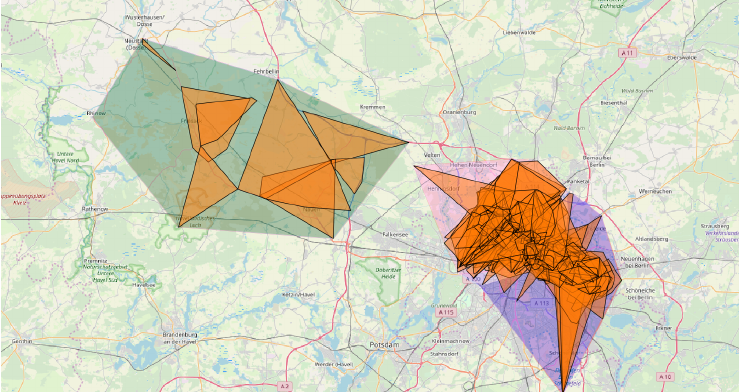
Figure 16. Administrative areas in the Berlin area: urban (violet and pink polygons) and rural (green polygon) area. Orange polygons represent cell coverage.